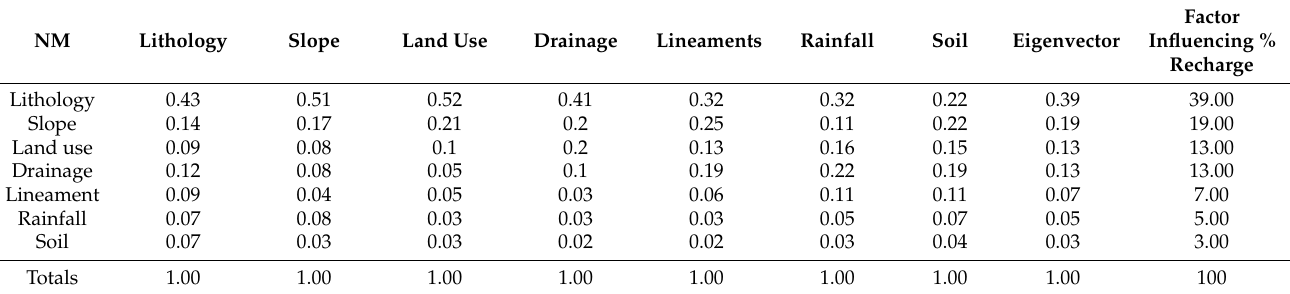
Table 6. Normalized matrix (NM) for weighs of influential factors on